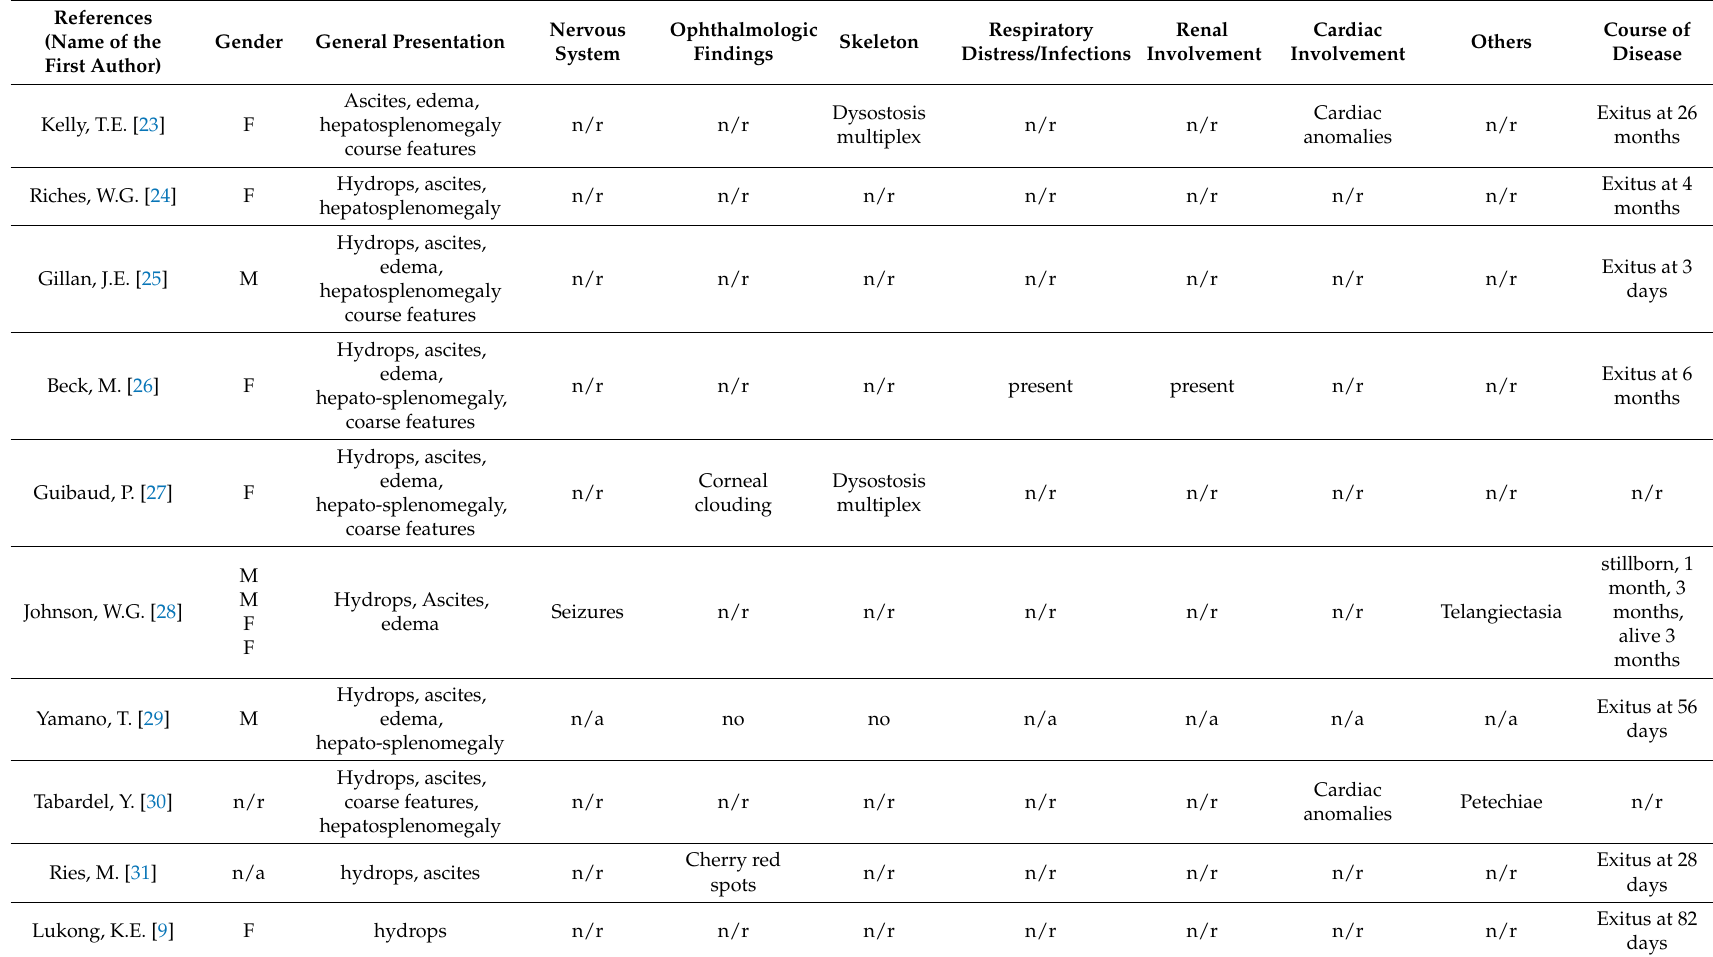
Table 1. Clinical and Morphological findings of patients suffering from sialidosis II, congenital subtype form. (Cases from 1980 until present are included). M = male; F = female; n/a = not available; n/r = not reported; no = not